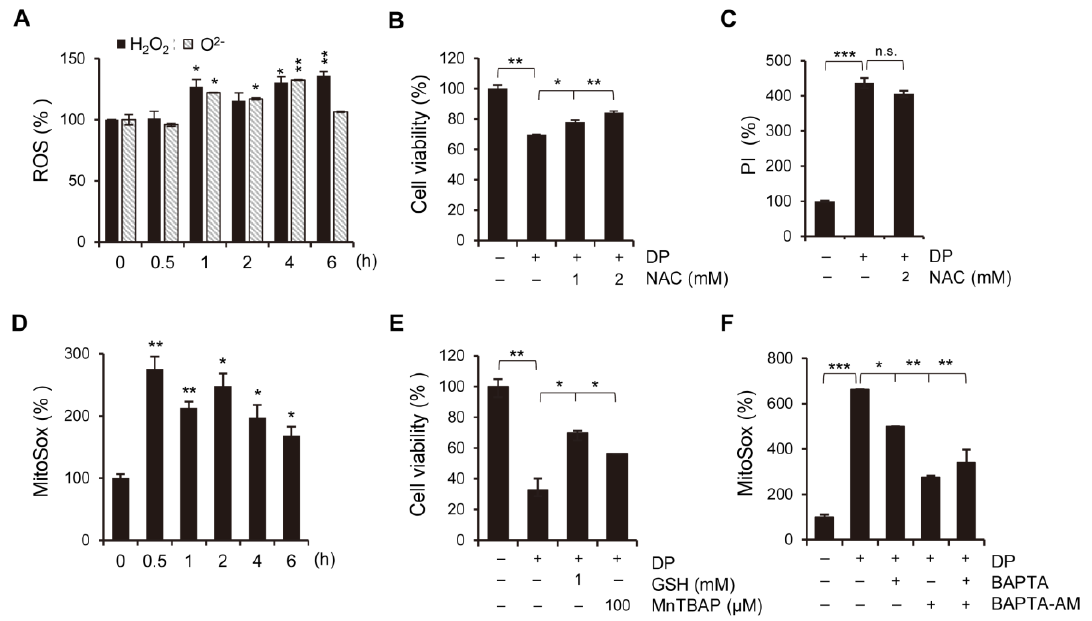
Figure 5. Mitochondrial Ca 2+ overload acts upstream of ROS production. ( A ) A549 cells were treated with 40 µ M DP for the indicated time. The cells were exposed to the hydrogen peroxide-sensitive dye H 2 DCF-DA and the superoxide-sensitive dye HE at 37 ◦ C for 20 min, and ROS production was then analyzed using flow cytometry. ( B , C ) A549 cells were pretreated with NAC and then further treated with 40 µ M DP. Cell growth was analyzed by the MTT assay ( B ), and the degree of PI staining was analyzed by flow cytometry ( C ). ( D ) A549 cells were treated with 40 µ M DP for the indicated time. The treated cells were incubated with MitoSOX for 20 min at 37 ◦ C in the dark and analyzed via flow cytometry. ( E ) A549 cells pretreated with GSH and MnTBAP, and further treated with 40 µ M DP for 24 h. Viability was assessed using the MTT assay. ( F ) A549 cells pretreated with Ca 2+ chelators and then incubated with MitoSOX for 20 min at 37 ◦ C in the dark and analyzed via flow cytometry. All data are expressed as the mean ± SD obtained from at least three independent experiments. Statistical differences were analyzed by two-way ANOVA with Tukey’s multiple comparisons test and presented as p < 0.05 (*), p < 0.01 (**), and p < 0.001 (***) compared with the control. n.s.: not